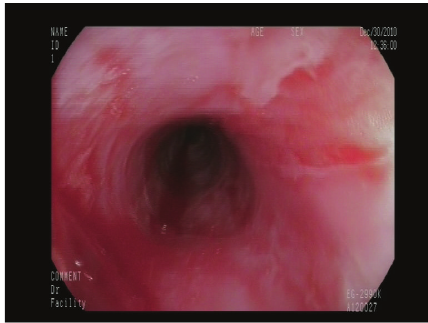
Figure 3: Peeling esophageal mucosa. Figure 4: IgG deposition along the basement